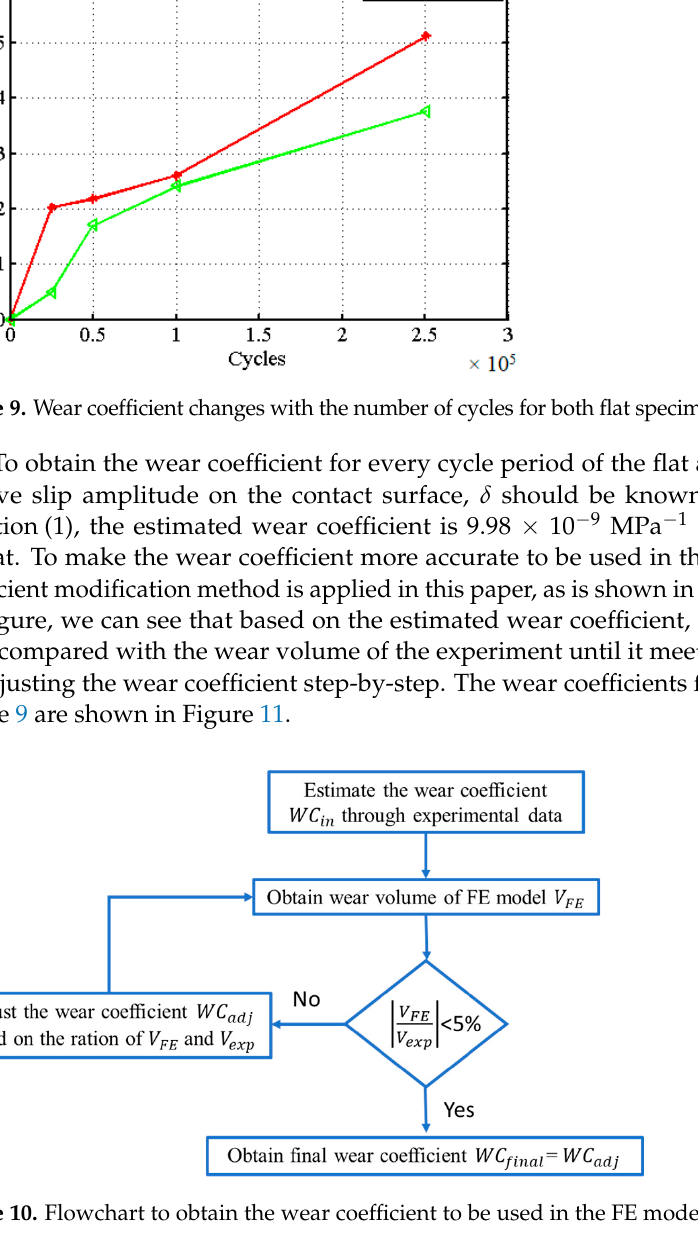
Figure 10. Flowchart to obtain the wear coefficient to be used in the FE model.